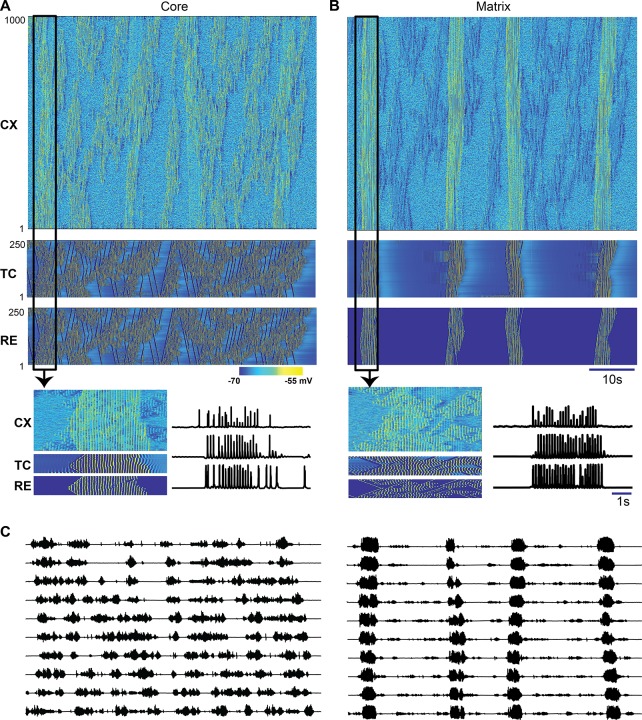
Spindle activity is different in the core and matrix systems.(A, B) Space-time plots of activity in the thalamocortical network including the core system (A) and matrix system (B). (C) Average network activity (simulated LFP) filtered between 6–15 Hz was measured from 10 non-overlapping locations (each group contains 100 PYs) of the cortical network. Note, spindles occur more frequently (but less synchronously) in L3/4 (left) and less frequent (but more synchronous) in L5 (right).